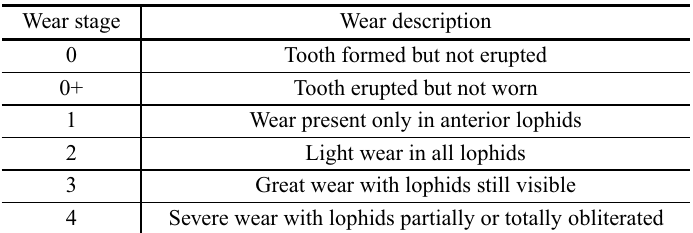
MolariformteethwearstagesestablishedbySimpsonandPaula-Couto, 1957. Intermediate stages correspond to the numbers 1, 2 and 3.